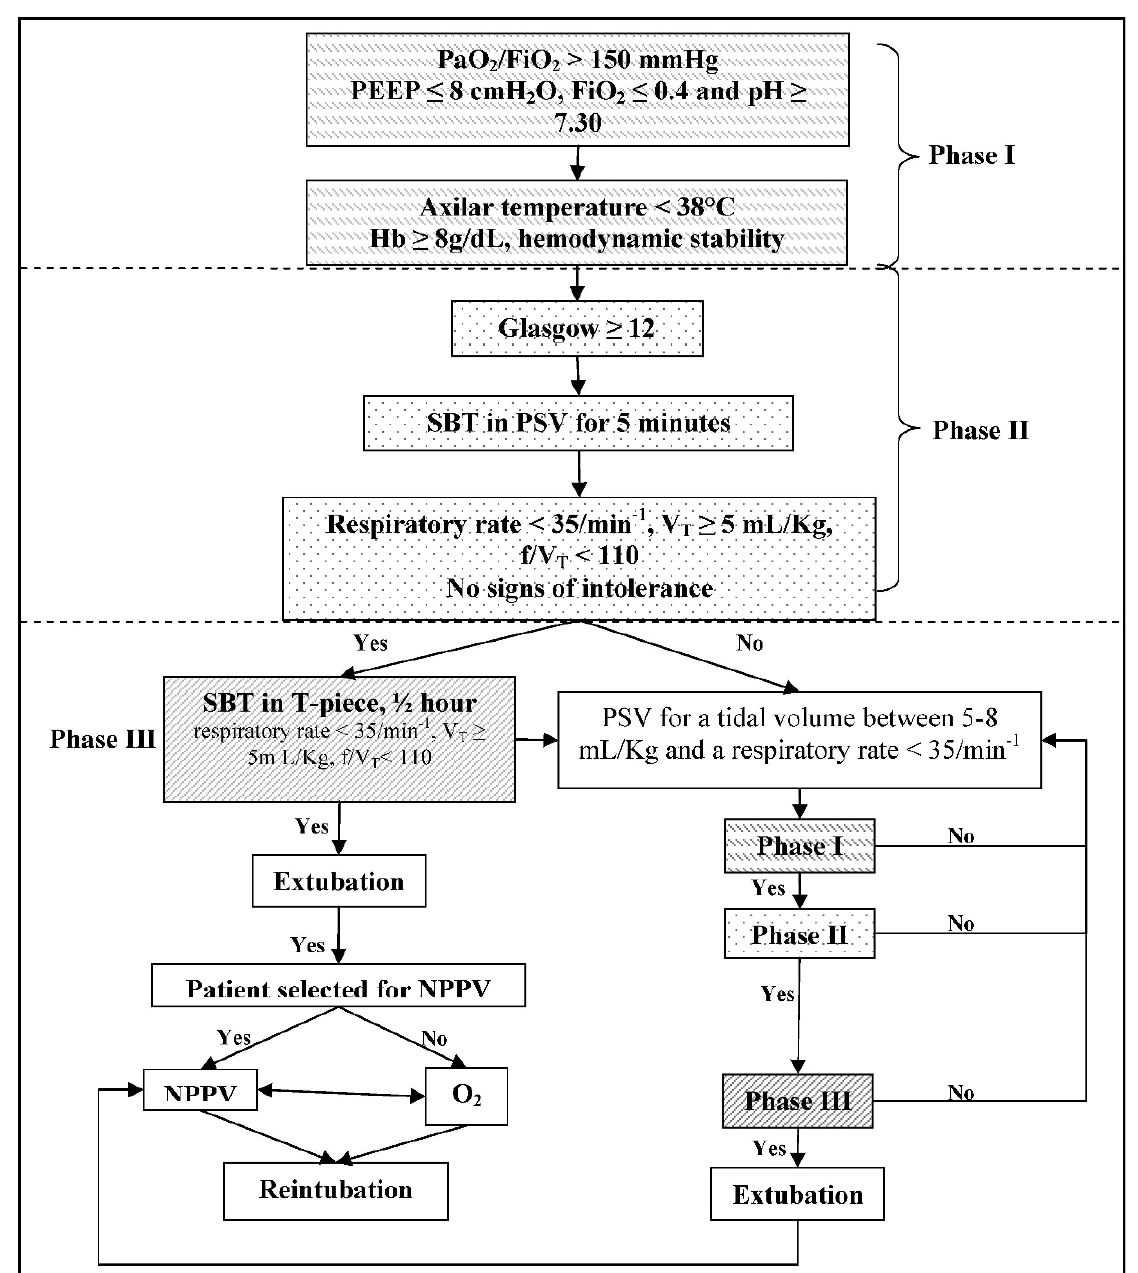
Figure 2 - Protocol design. IMV invasive mechanical ventilation; PEEP positive end-expiratory pressure; Hb hemoglobin; SBT spontaneous breathing trial; PSV pressure-support ventilation; MIP maximum inspiratory pressure; V T tidal volume; f/V T respiratory frequency to V T ratio; NPPV non-invasive